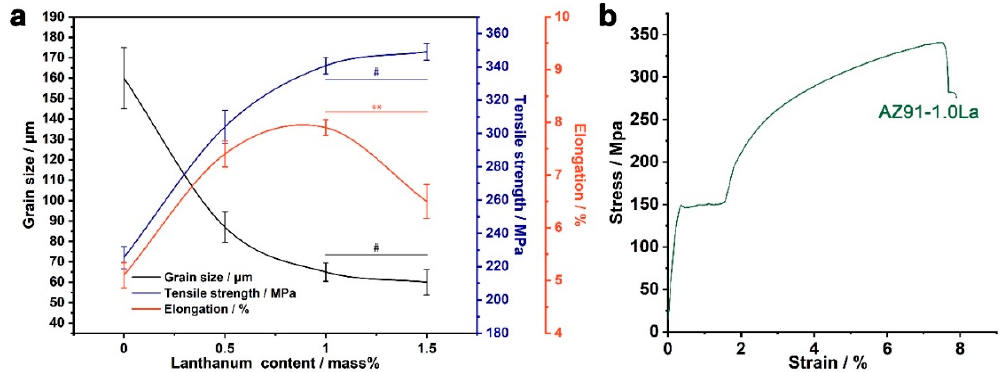
Figure 7. ( a ) The mechanical properties and average grain size of AZ91 alloy with different amounts of lanthanum content; ( b ) the stress–strain curve of AZ91–1.0La alloy; mean value ± SD is presented.